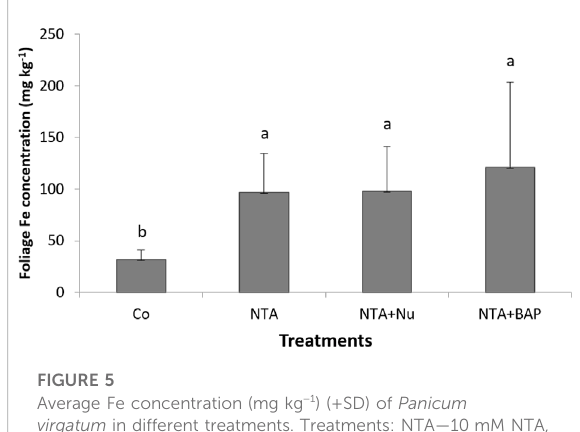
FIGURE 5 Average Fe concentration (mg kg − 1 ) (+SD) of Panicum virgatum in different treatments. Treatments: NTA — 10 mM NTA, Nu — foliar nutrients application of Triple-12 ® , BAP- Promalin ® foliar application. Means for columns with same letters are not signi fi cantly different ( α =